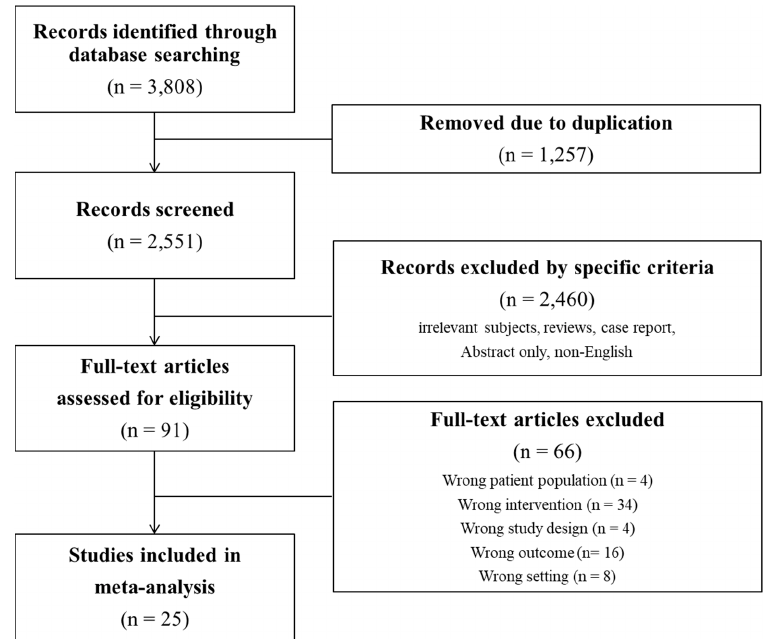
Figure 1. Flow charts of the study. Table 1. Demographics and characteristics of studies included in the systematic review and meta- analysis.